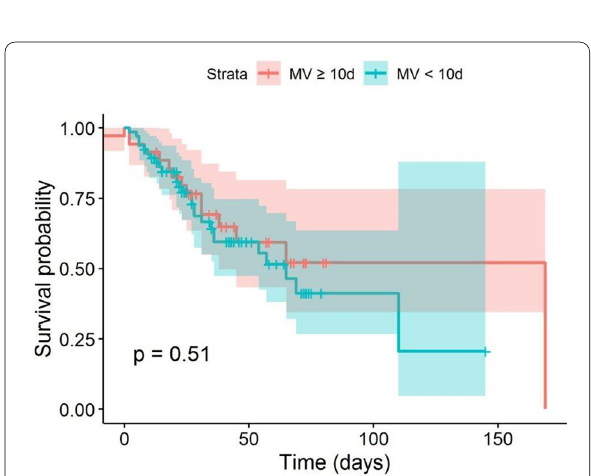
Fig. 2 Survival probabilities plotted for all patients grouped by